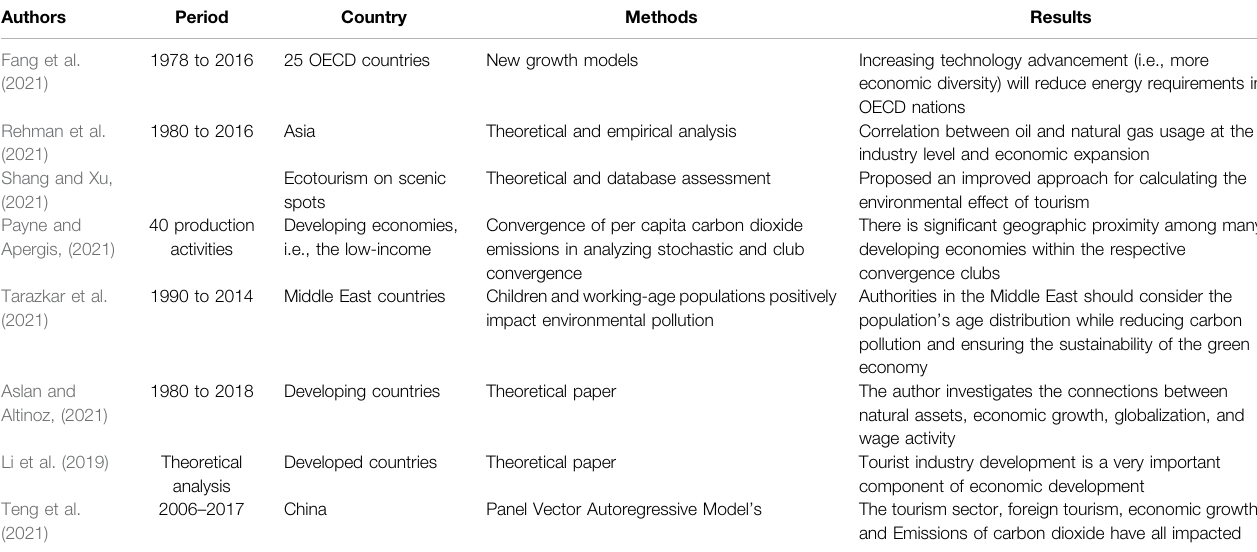
TABLE 1 | Literature summary on economic growth, environmental issues, and energy consumption.